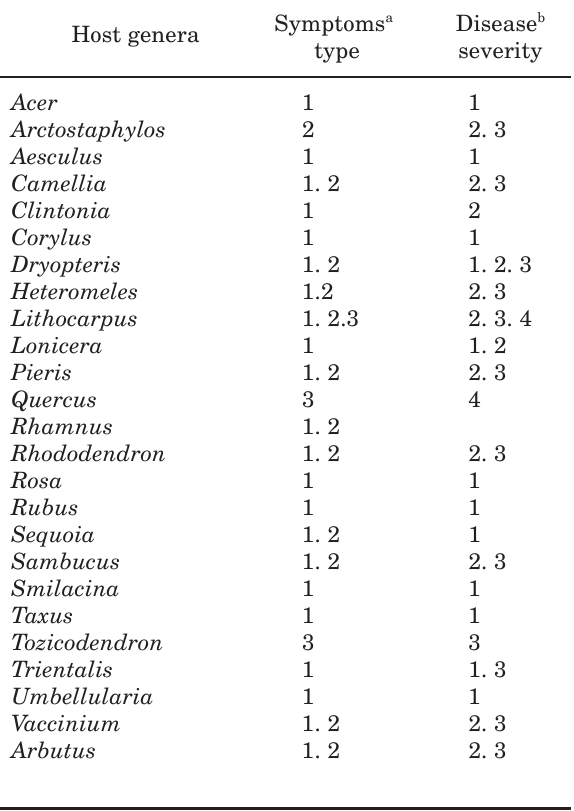
Table 1. Plant hosts susceptible to Phytophthora ramo- rum in western North America, including type of symp- toms described for each host and recorded disease se-